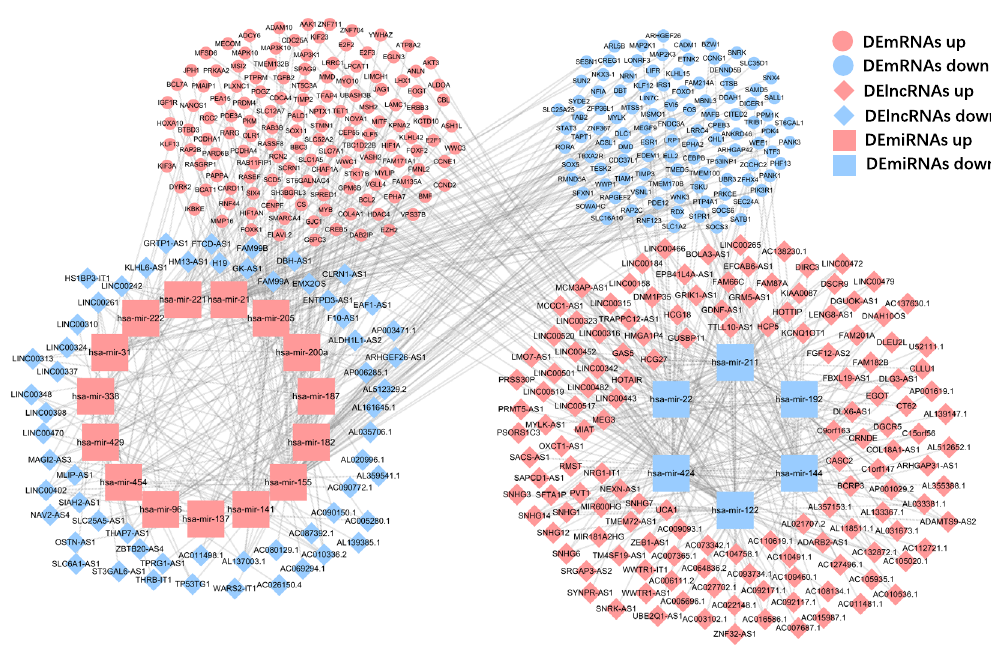
Figure 4. Construction of the ceRNA network on 200 lncRNAs nodes, 21 miRNAs nodes, and 245 mRNAs nodes with 434 lncRNA-miRNA pairs and 284 miRNA-mRNA pairs; the shape represents the type of RNA, blue means down-regulation in cancer samples, and red means up-regulation in cancer diagram (Fig. 4) in which the lncRNA-miRNA pairs with the same ascending and descending relationship were deleted, including 200 lncRNAs nodes, 21 miRNAs nodes and 245 mRNAs nodes with 434 lncRNA-miRNA pairs and 284 miRNA-mRNA pairs. The prediction results of lncRNA-miRNA pairs (Supplementary Table S1) and miRNA-mRNA pairs (Supplementary Table S2) in the database are shown in the supplementary material.